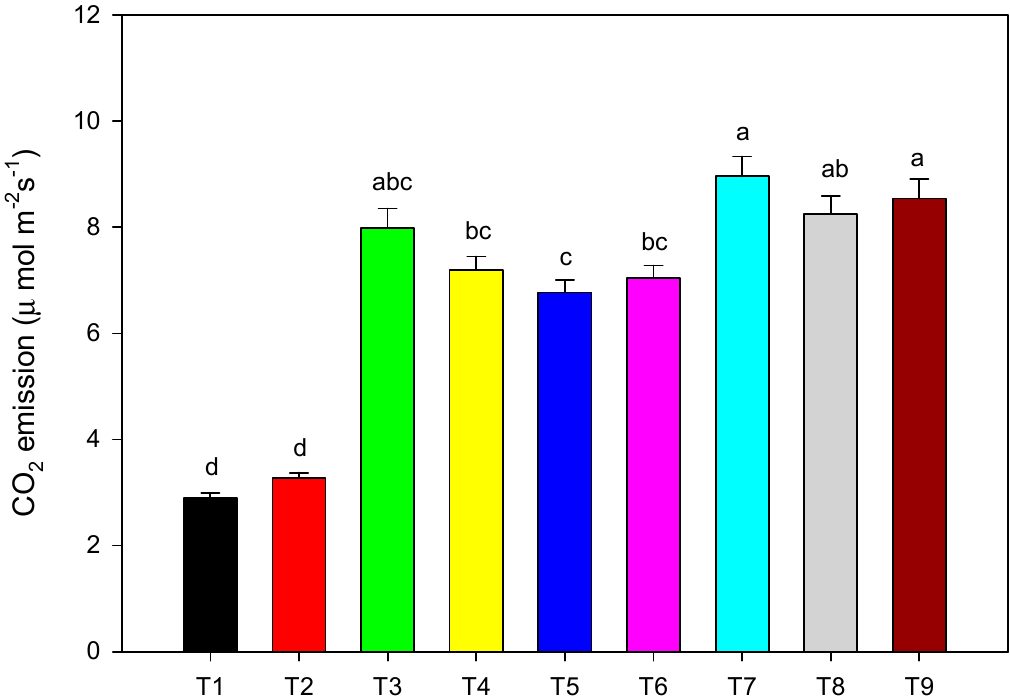
Figure 2. Average CO 2 emission rate across all measured dates. Same letters are not significantly different above bar at p ≤ 0.05. T 1 = No treatments and fertilizer (Control), T 2 = Recommended rate of NPK (t ha − 1 ), T 3 = 100% dolomitic limestone, T 4 = 100% dolomitic limestone + 10 t ha − 1 rice husk biochar, T 5 = 75% dolomitic limestone + 10 t ha − 1 rice husk biochar, T 6 = 75% dolomitic limestone + 15 t ha − 1 rice husk biochar, T 7 = 100% dolomitic limestone + 10 t ha − 1 oil palm empty fruit bunches biochar, T 8 = 75% dolomitic limestone + 10 t ha − 1 oil palm empty fruit bunches biochar, T 9 = 75% dolomitic limestone + 15 t ha − 1 oil palm empty fruit bunches biochar.